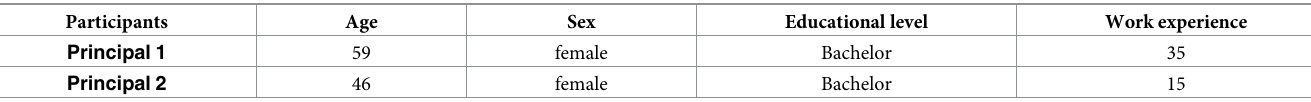
Table 2. Demographics characteristics and work experience of two principals of preschools.